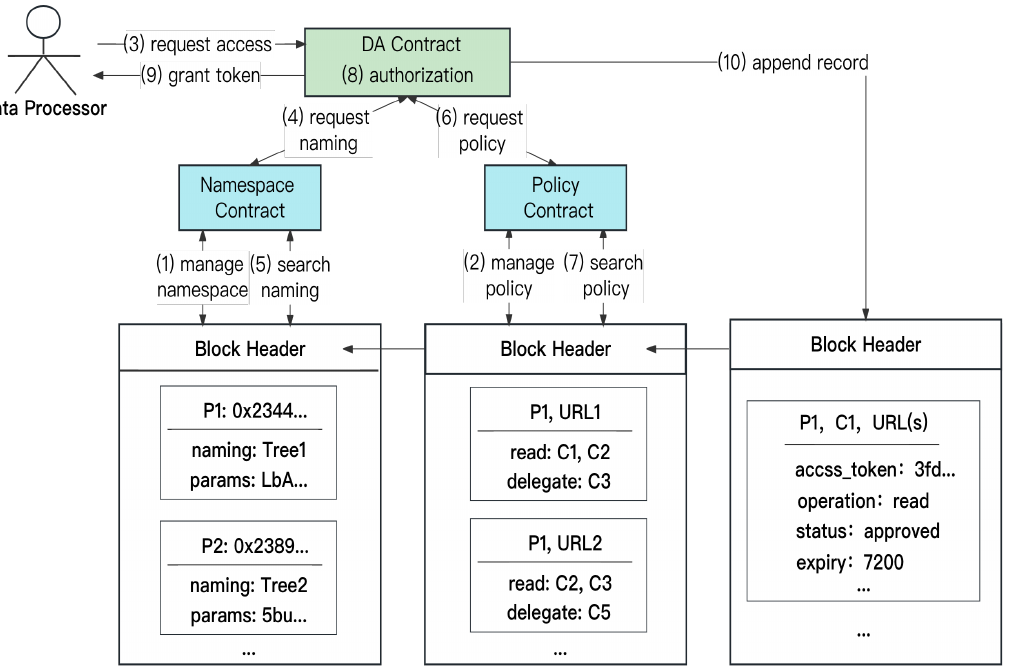
Figure 6. Decentralized Authorization